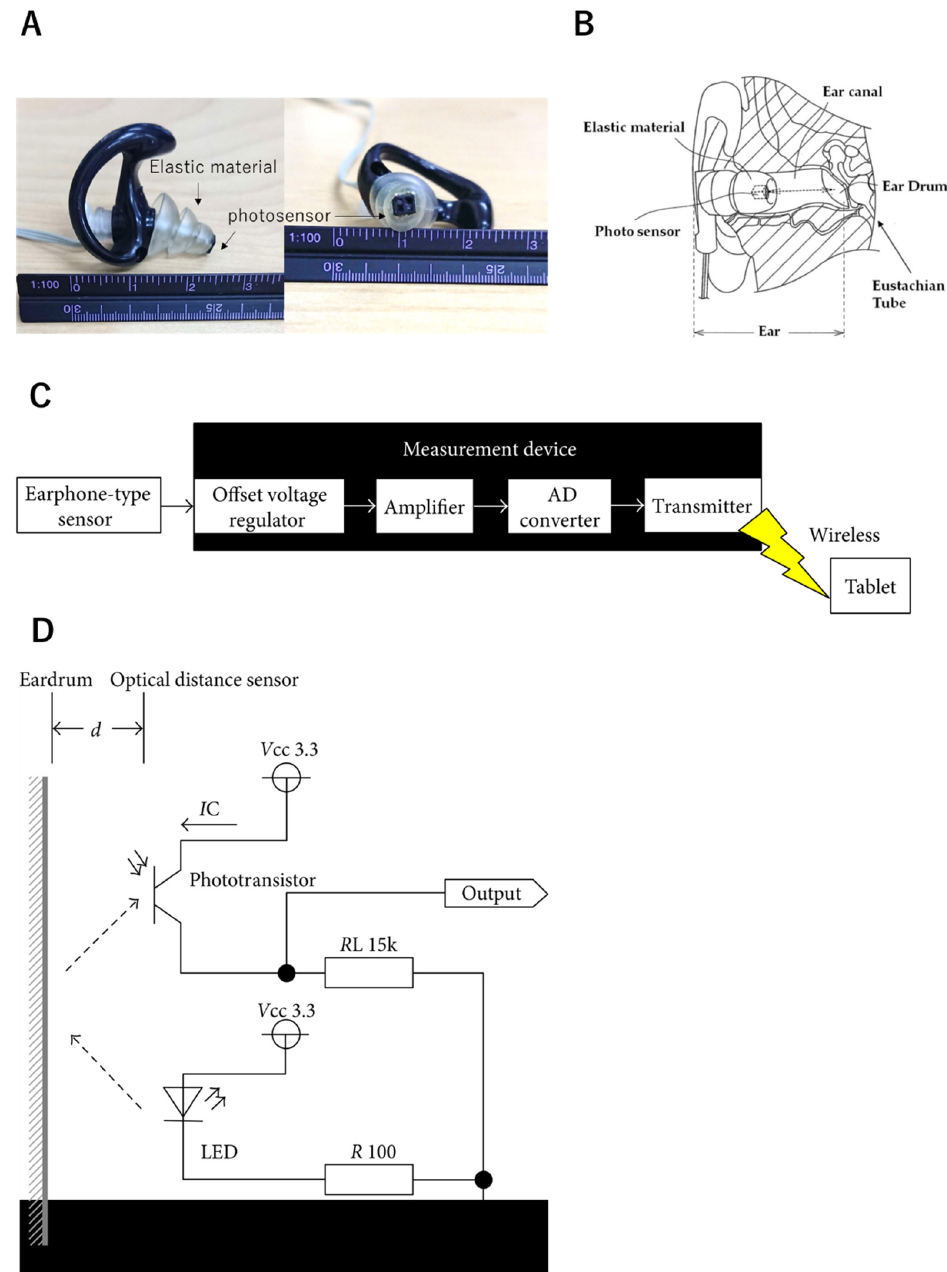
Figure 1. Earphone-type sensor. ( A ) Shape of the sensor used in this study. Elongation of the elastic material at the tip improved the sensor and allowed it to reach the eardrum. Since the elastic region models its shape to fit the shape of the ear canal, the sensor can accommodate for the individual differences in the shape of the ear canal. ( B ) The mechanism and structure of the earphone-type sensor. A small optical sensor is mounted on the tip of the sensor, and a light-emitting diode (LED) and a phototransistor are incorporated. By irradiating the ear canal with infrared light using an LED (wavelength 960 nm) and moving the irradiated area, changes in the reflected light emitted can be detected. When the phototransistor captures the reflected light signals, it detects the movement of the ear canal, including the eardrum. The light energy of the detected light is converted and ampli- fied into electrical energy, and the signal is converted into a digital signal using an analog–digital (AD) conversion circuit (10 bits, 250 Hz). The results of these measurements can be captured and are recorded on a tablet terminal at a remote location using Bluetooth. ( C ) Configuration of the measurement device. ( D ) Electronic circuits surrounding the lightwave distance sensor.